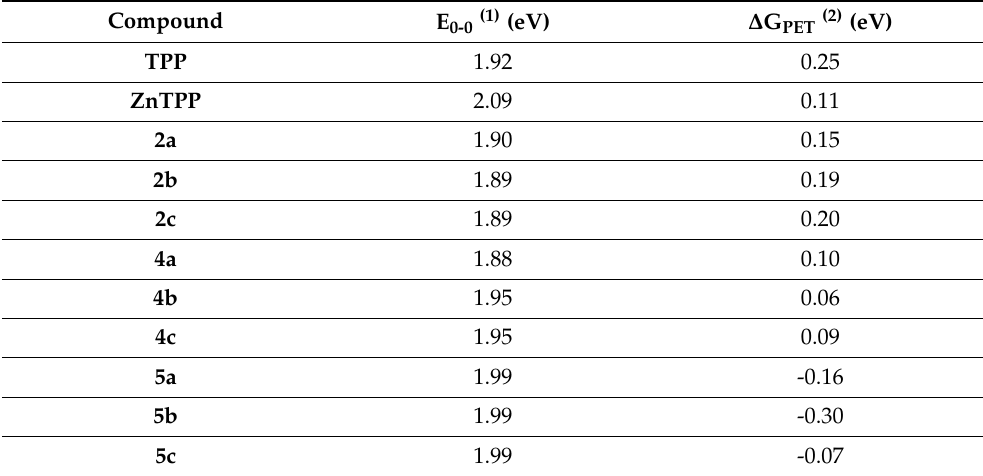
Table 3. Zero-to-zero transition and free energy data for TPP , ZnTTP , 2a–c , 4a–c , and 5a–c . Compound E 0-0 (1) (eV) ∆ G PET (2) (eV) TPP 1.92